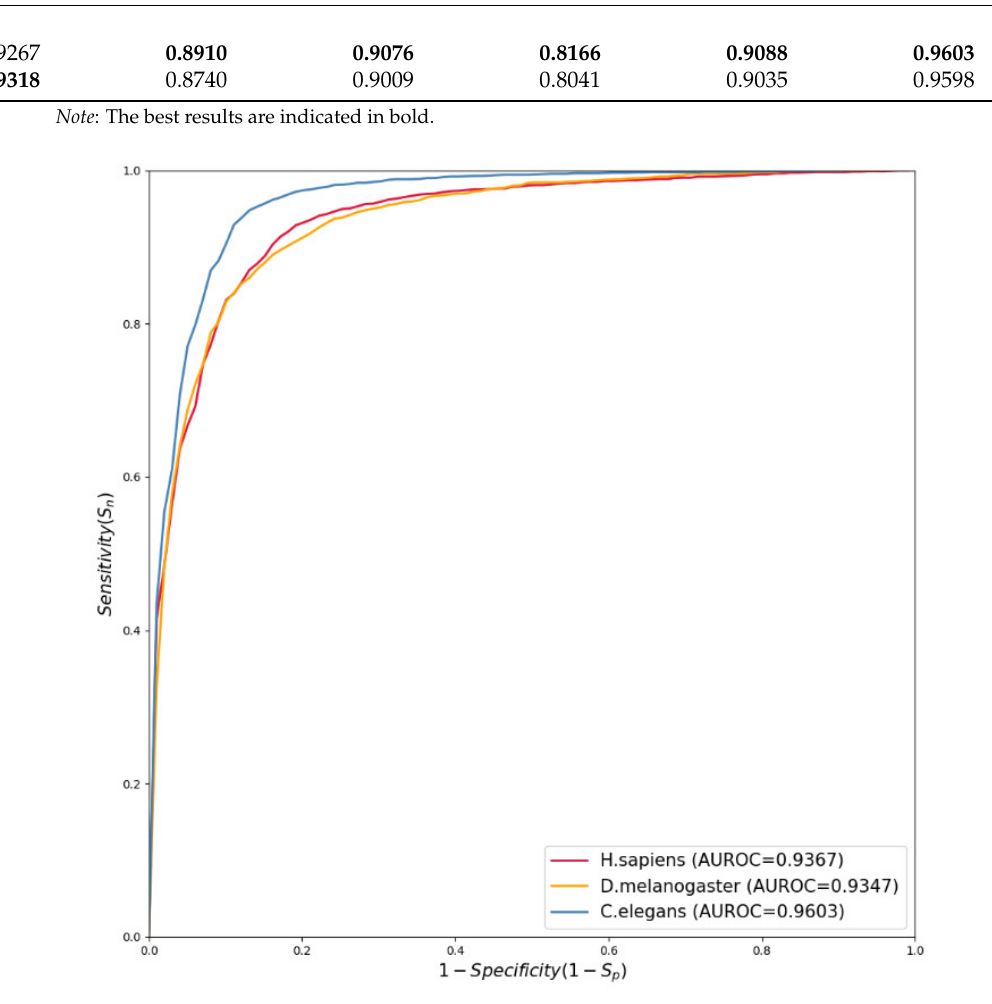
Figure 2. ROC curves plotted based on 10-fold cross validation test results across 3 species. Subsequently, we compared the prediction performance of DeepNup with that of two baseline methods, i.e., iNuc-PseKNC [35] and DLNN-5 [43]. iNuc-PseKNC was proposed based on SVM, and DLNN-5 is a DL-based method. The results of comparison between DeepNup and iNuc-PseKNC, DLNN-5 in three species were shown in Table 5. As seen from Table 5, for H. sapiens , DeepNup outperforms the other two baseline methods in terms of all the six metrics, and for D. melanogaster and C. elegans , DeepNup has a better performance than iNuc-PseKNC in terms of the five metrics, and than DLNN-5 in terms of S p , ACC , MCC , and AUROC . In terms of the major metric AUROC , the values of AUROC are increased by 3.26% and 2.89% on average of three datasets, respectively. These results demonstrated that DeepNup is a powerful DL-based tool for nucleosome positioning